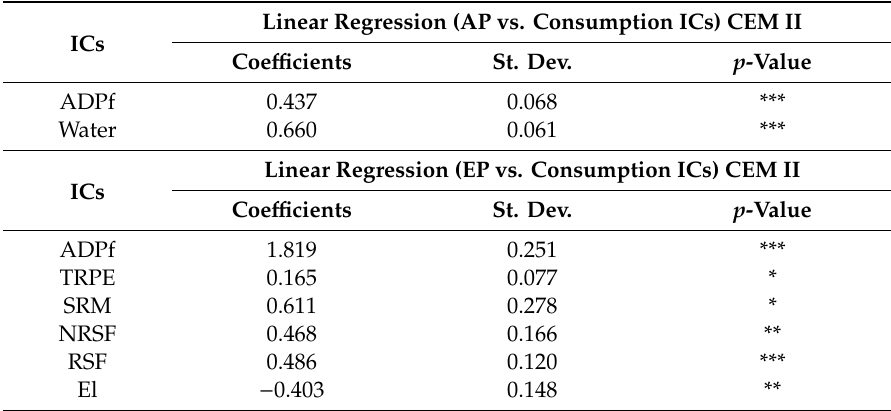
Table 23. GWP significant—AIC selection regression summary—CEM